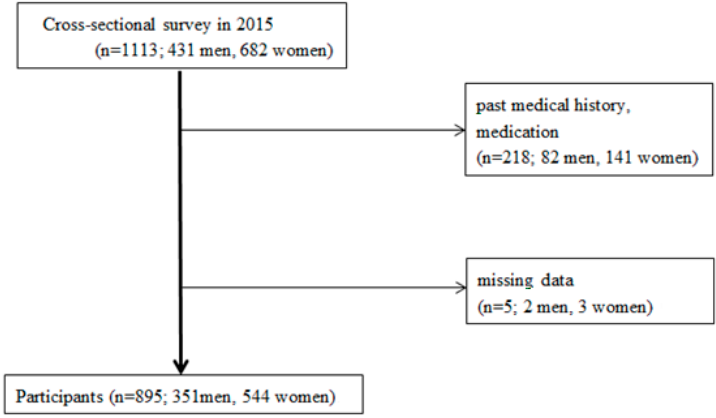
Figure 1. Flowchart of study